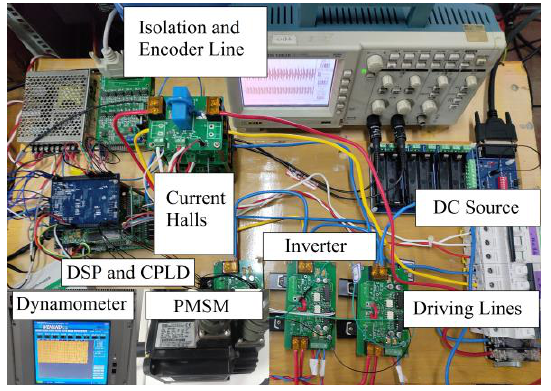
Figure 12. Experimental setup.